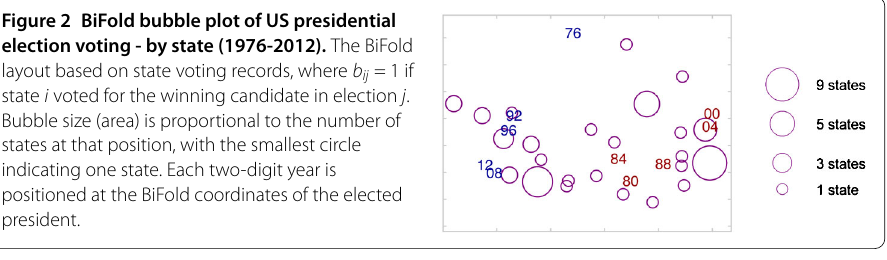
Figure 3 BiFold of US presidential election - visual enhancement. (a) States are colored based on the fraction of elections for which they supported the Republican (red) or Democrat (blue) presidential candidate. (b) Lines are added to connect Carter (‘76) and Reagan (‘84) to their respective “supporting” states in those elections. The boldness of the lines are proportional to the number of supporting states. (c) Similar support representation for Bush ‘00 and Obama ‘12 illustrate the strong partisan nature of those elections.